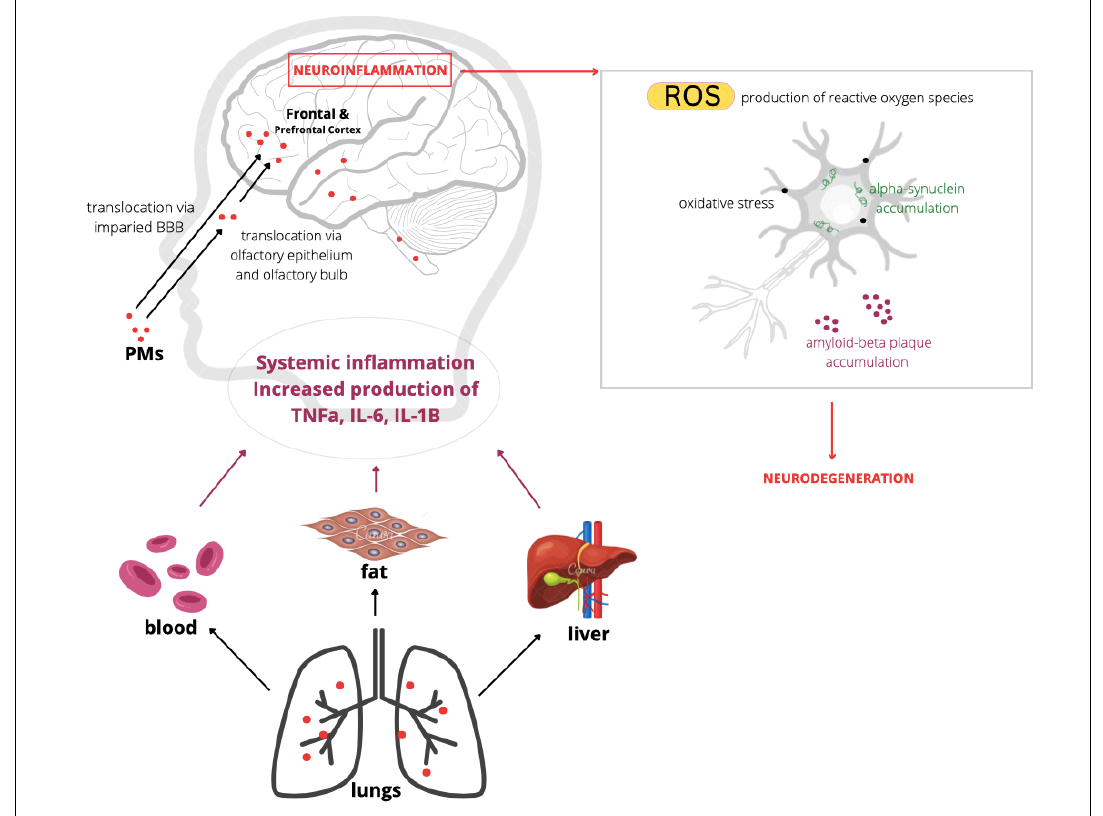
Figure 2. Example of mechanisms of action leading to developmental neurotoxicity from inhalation of particulate matter. Note: TNFa, tumor necrosis factor alpha; IL-6, interleukin-6; IL-1B, interleukin-1 beta; BBB, blood–brain barrier; ROS, reactive oxygen species. Reused with author’s permission, from [5]) .